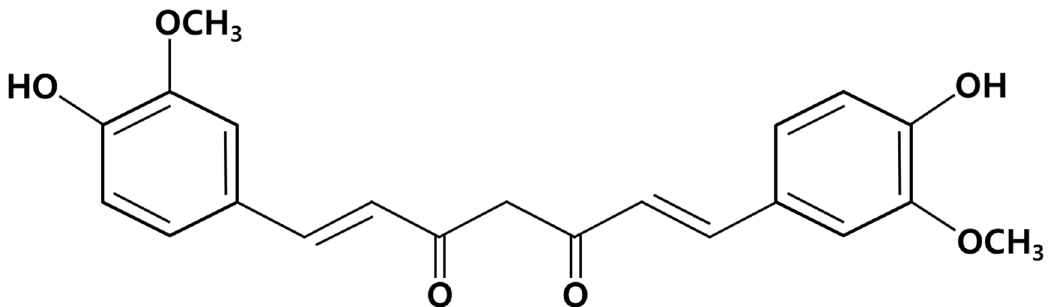
Figure 1. The structure of